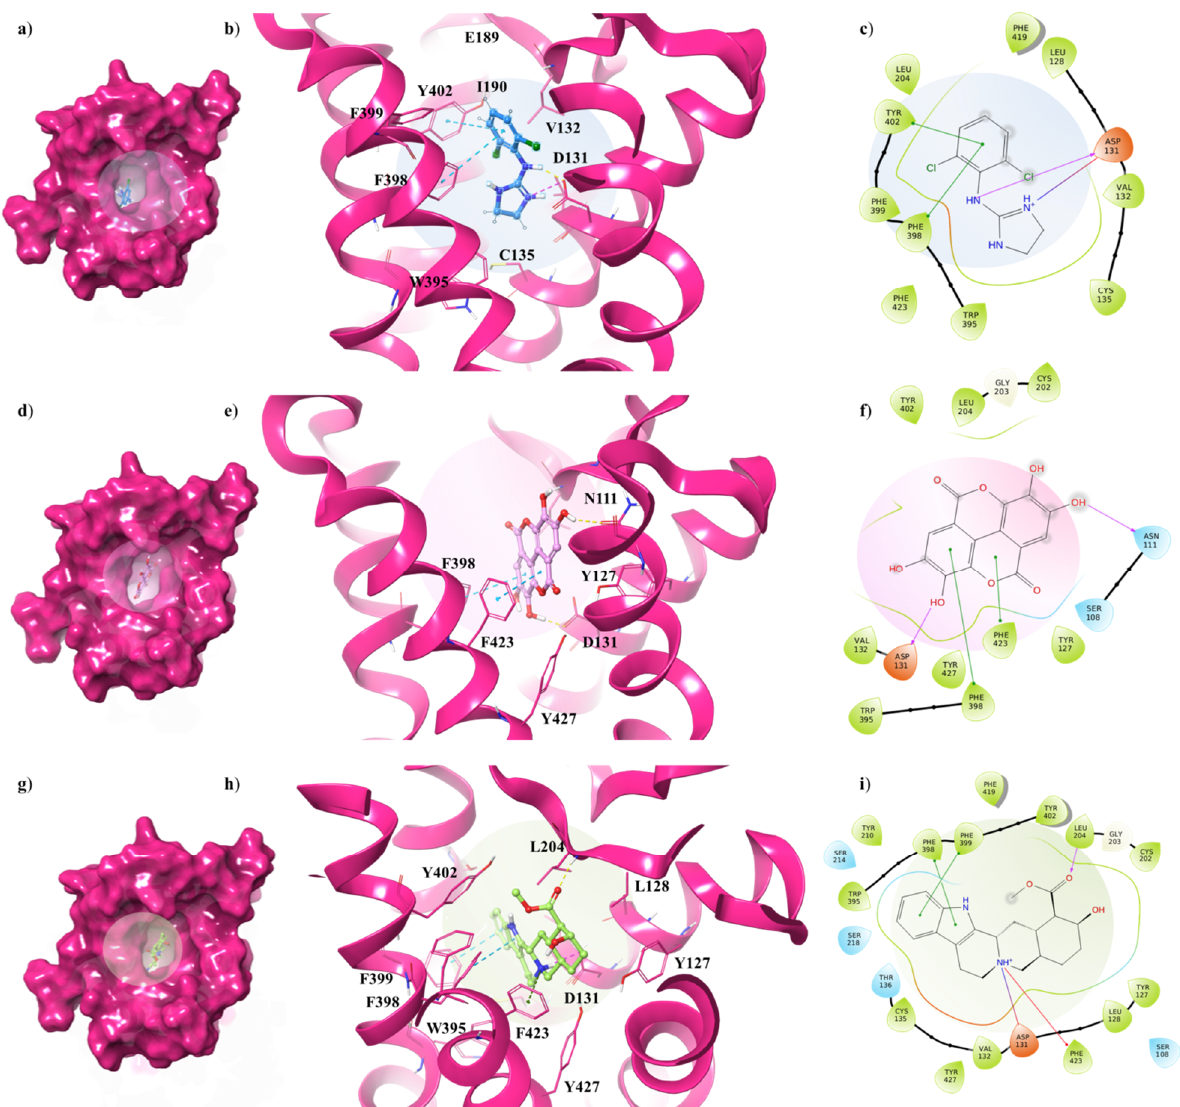
Figure 6. Key contacting elements inside ( a – c ) the α 2A -AR 6KUW /clonidine, ( d – f ) the α 2A -AR 6KUW /EA, and ( g – i ) the α 2 A- AR 6KUW /yohimbine best docked pose. Panels ( b , e , h ) show all side chains involved in H-bonds (violet), π - π interactions (cyan) and π -cation interactions (red) in stick representation. Panels ( a , d , g ) show the surface area of α 2A -AR 6KUW complexed to clonidine, EA and yohimbine, respectively. The surface area of the receptor is shown in solid magenta. 2D representation of the key interactions of ( c ) clonidine, ( f ) EA and ( i ) yohimbine into α 2A -AR 6KUY structure. The antagonist is surrounded by nine aromatic residues (Y127, Y210, W395, F398, F399, Y402, F419, F423, Y427) on TM6 and TM7, and three other residues (L128, V132, L204) forming the hydrophobic environment of the binding cavity. The indole moiety interacts with F398 and F399 by means of two π-π interactions, while the carboxyl group engages a H-bond with L204, one of the pivotal residues in establishing subtype selectivity [47]. EA is well accommodated into the α 2C -AR pocket and interacts with the same residues with which yohimbine interacts, except that one hydroxyl group of EA is in contact with N111 (Figure 6d–f). Finally, analysing the interactions between clonidine and